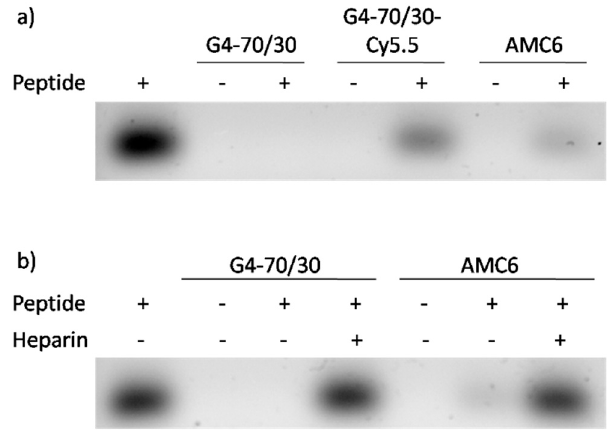
Figure 2. Binding of the fluorescent peptide to the G4-70/30 dendrimer and AMC6 nanoparticle release by heparin. ( a ) Binding of the peptide to G4-70/30 (20 µM), G4-70/30-Cy5.5 (20 µM) and AMC6 (3 µM) increases the size of the complex, decreasing its migration in the agarose gel, and it is visualized as the decrease in the peptide band. Complexes were run on the gel after 24 h of incubation at RT. ( b ) Heparin added to the complex, competes with the peptide for the dendrimer, and causes a release of the peptide.